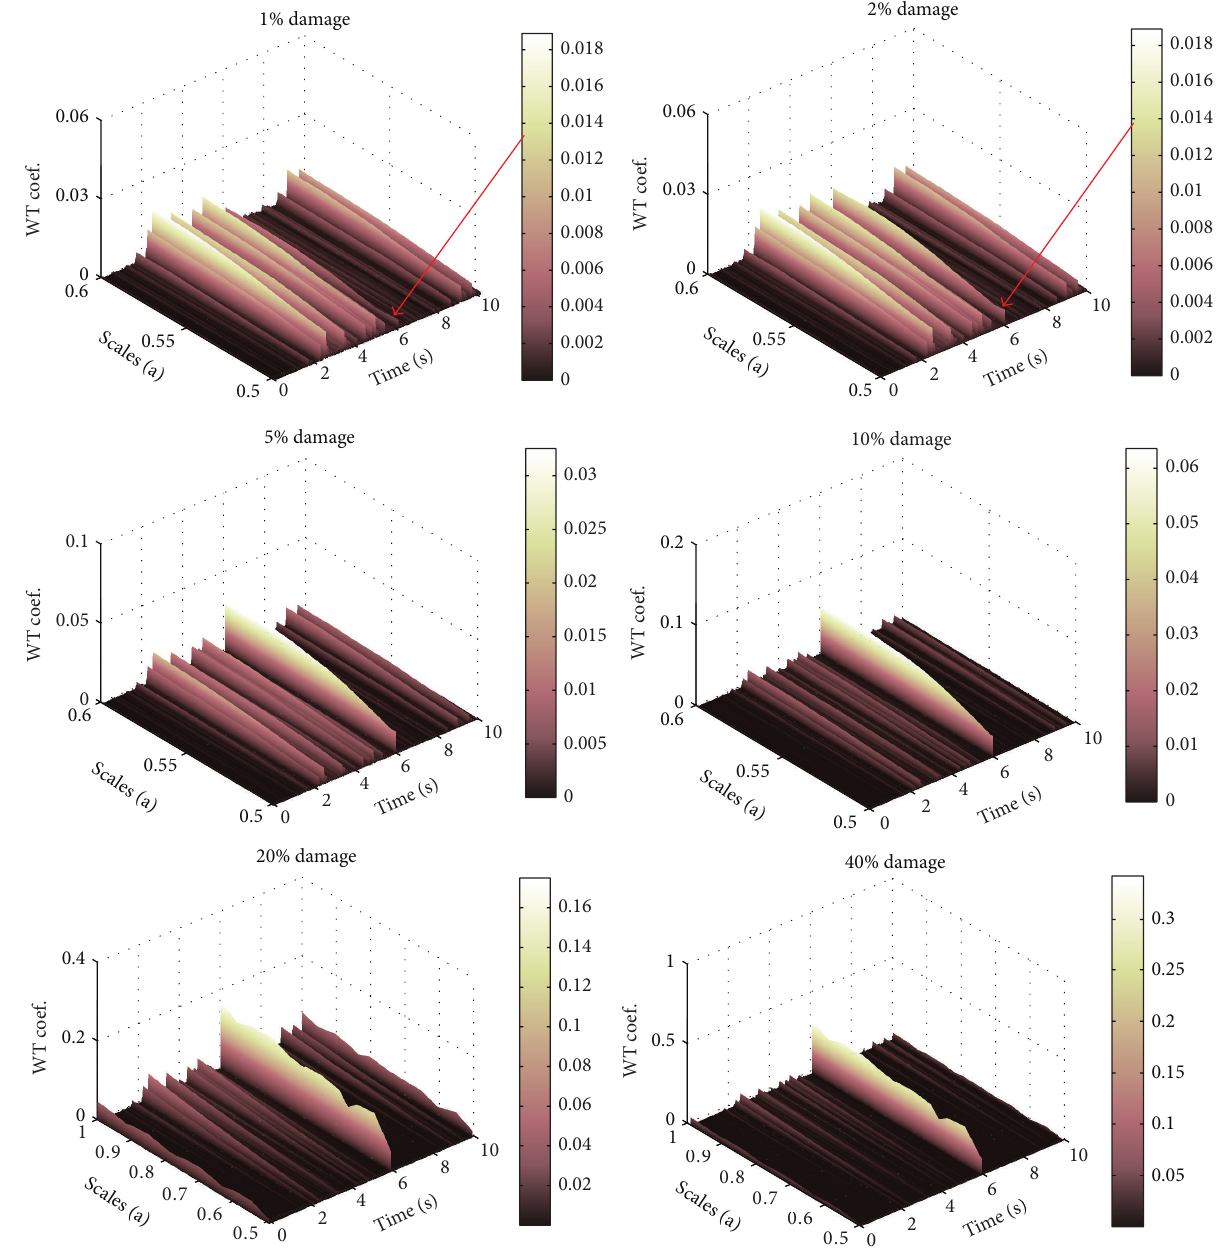
Figure 6: Detection results for various severities under seismic